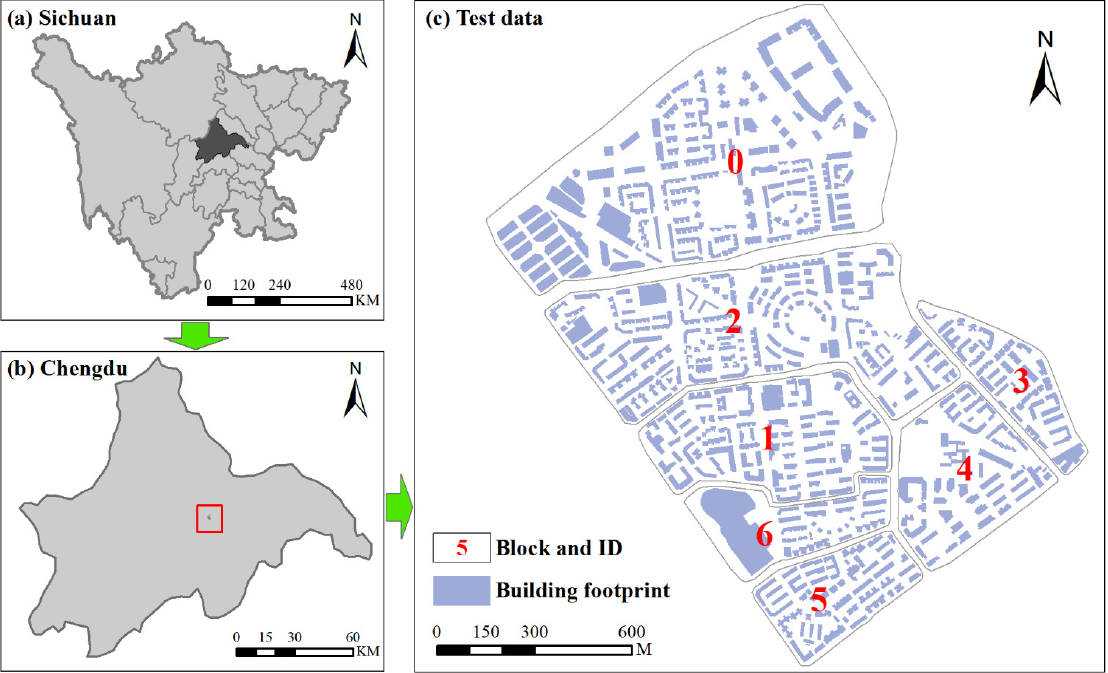
Figure 1. Location of the study area and the experimental data are shown for ( a ) Sichuan Province, China, ( b ) the capital city of Sichuan Province, and ( c ) the experimental data.